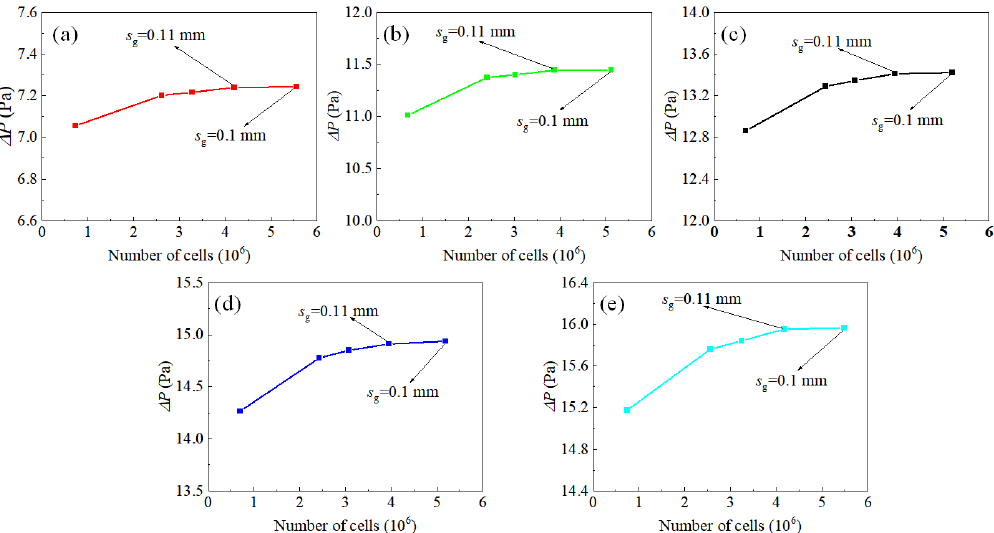
Figure 4. Influence of mesh size on the bed pressure drop in different packed beds: ( a ) b100; ( b ) b75s25; ( c ) b50s50; ( d ) b25s75; ( e ) s100.